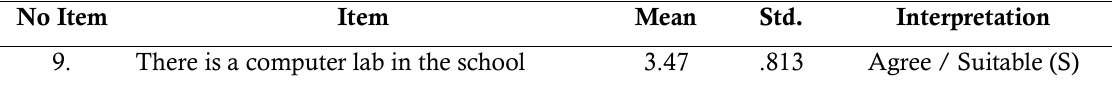
Table 4 . Student Responses to Learning Facilities at